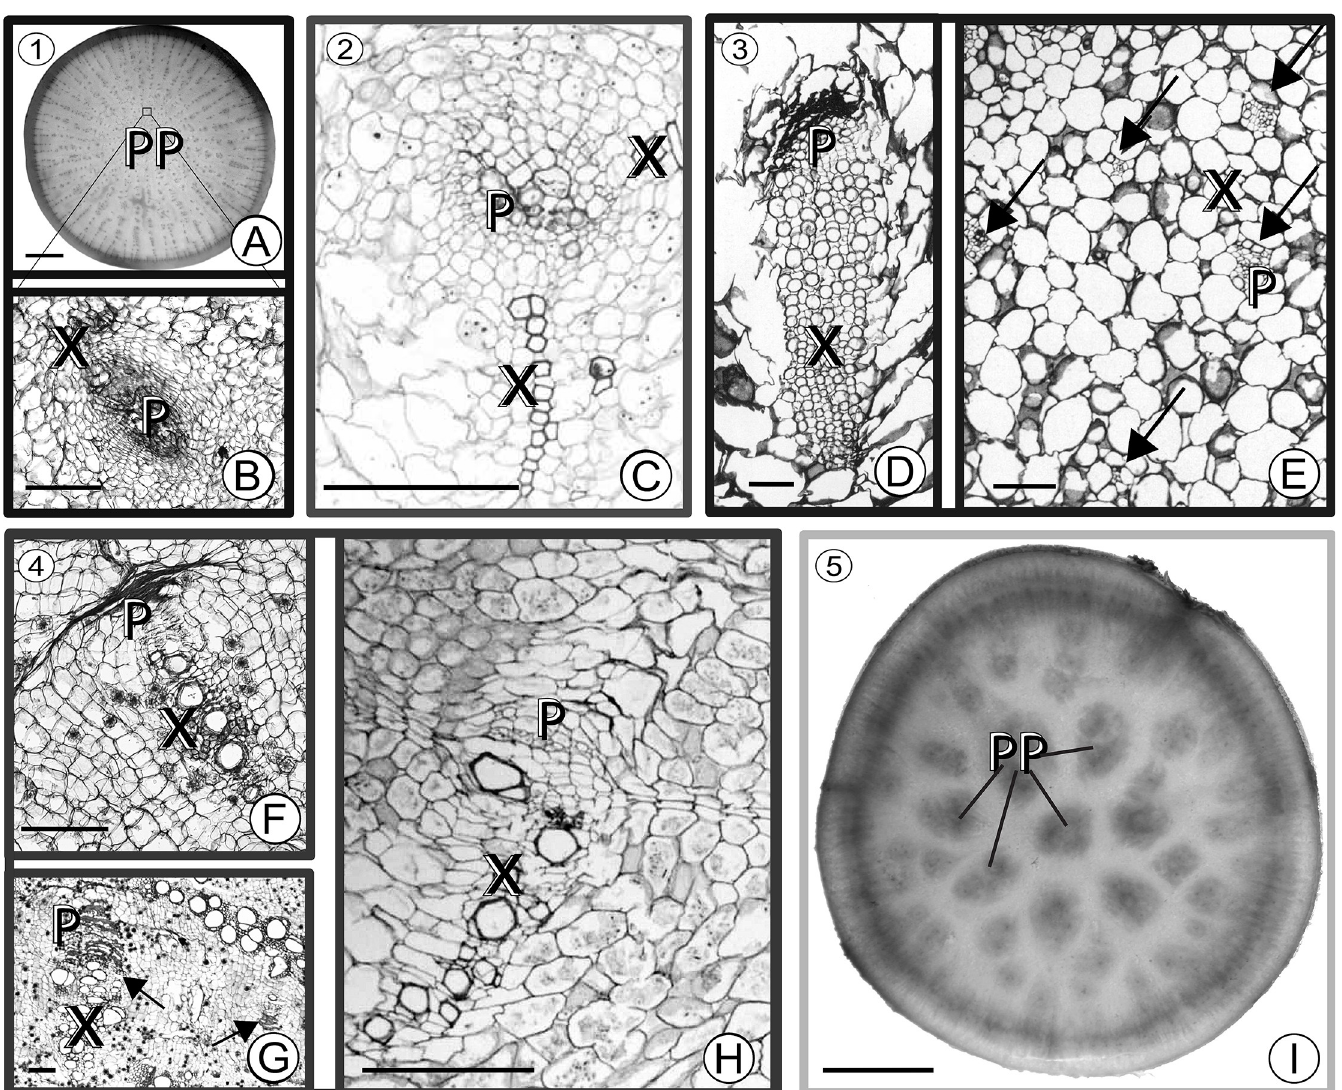
Fig 1. Multiple evolutionary origins of supplemental vascular bundles in stems and roots. (A) Turnip [ Brassica rapa rapa (Brassicaceae)] tuberous root cross section. Small dots in the center of the section are vascular bundles in a zone where parenchyma cells are proliferating (PP). (B) Close-up of vascular bundle in turnip root tuber. A small zone of xylem (X) encircles crushed internal phloem (P) in the amphivasal bundle arrangement. (C) Older medullary SVB (i.e., SVB in pith) from stem of Pachypodium namaquanum (Apocynaceae) with two zones of xylem and a zone of phloem interior to the xylem. (D) Close-up of an old medullary SVB from the trunk of Trichocereus chilensis (Cactaceae) showing a long tail of xylem and phloem that is capped with crushed secondary phloem (dark band). (E) Cross section of young stem just below the shoot apical meristem of Subpilocereus ottoni (Cactaceae) showing the distribution of five medullary SVBs (arrows). (F) Old collateral vascular bundle from root tuber of Adenia inermis (Passifloraceae). (G) Large (note scale) collateral medullary SVBs from stem of Adenia metamorpha . (H) Old collateral medullary SVB from stem of Adenia keramanthus . (I) Cross section through tuberous root of Ipomoea batatas (Convolvulaceae). Dark spots in the center of the root are zones of proliferating parenchyma and vascular bundles. Taxonomic orders (numbered blocks) 1 –Brassicales; 2 –Caryophyllales; 3 –Gentianales; 4 –Malpighiales; 5 – Solanales. Scale: (A), (J)– 10mm; (B)-(H)– 250 μ m. (C) adapted from [29] with permission; (D), (E) adapted from [32] with permission.